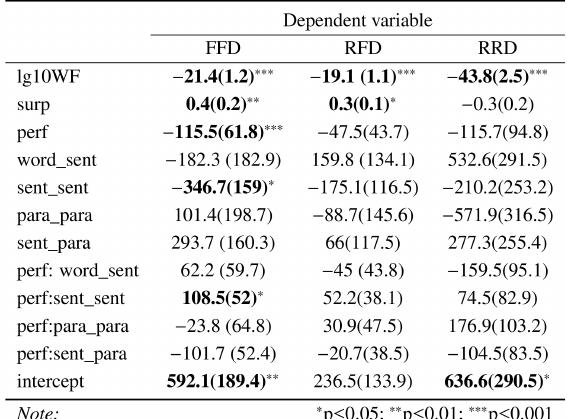
Figure 6. FFD as a function of current and preceding sentence similarity and reading ability: random effects